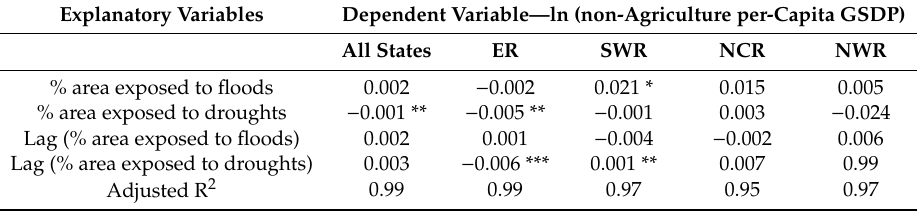
Table 6. Regressions on flood and drought-a ff ected areas with non-agriculture per-capita